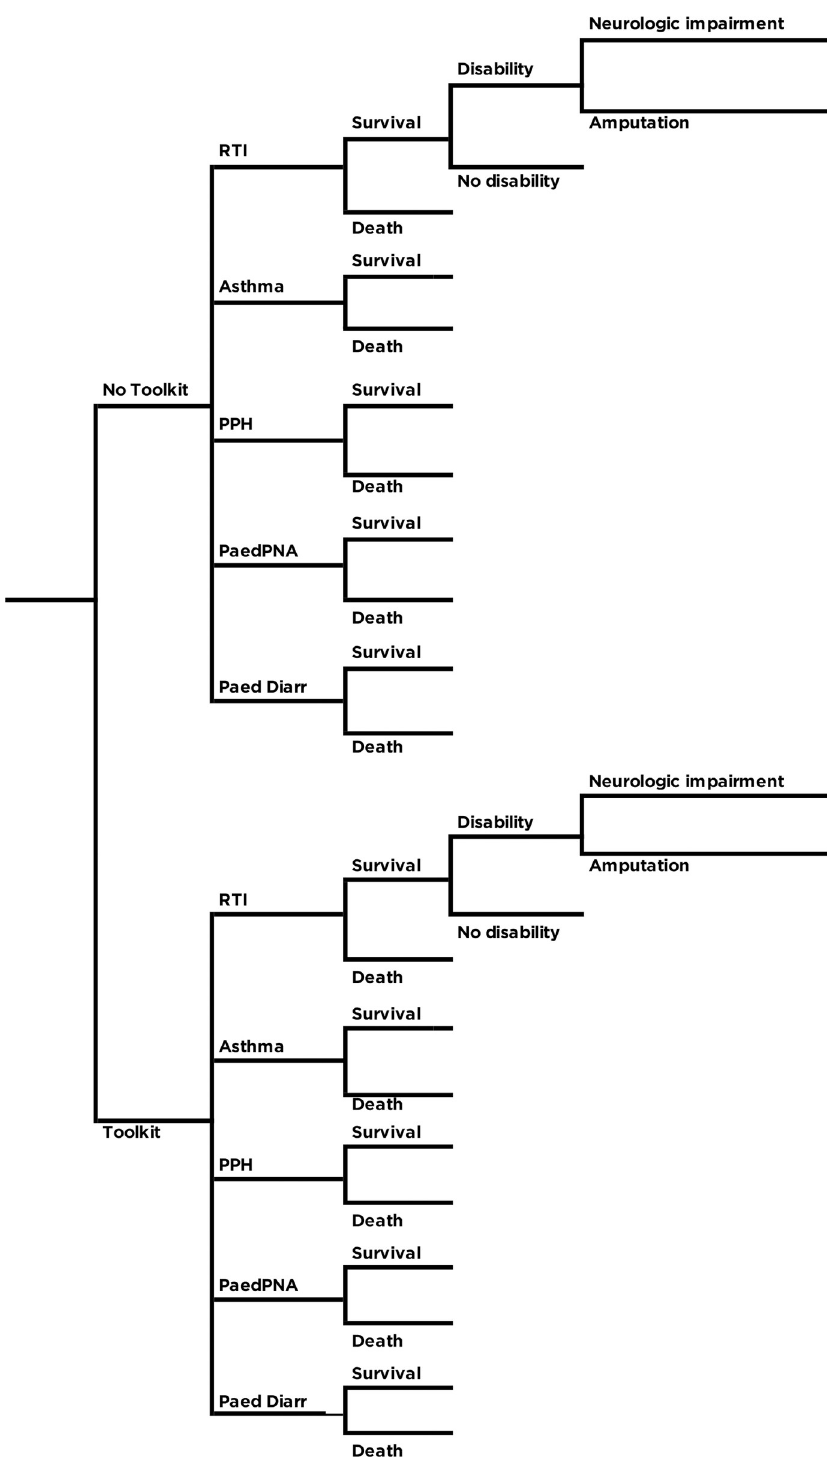
Fig 1. Decision tree